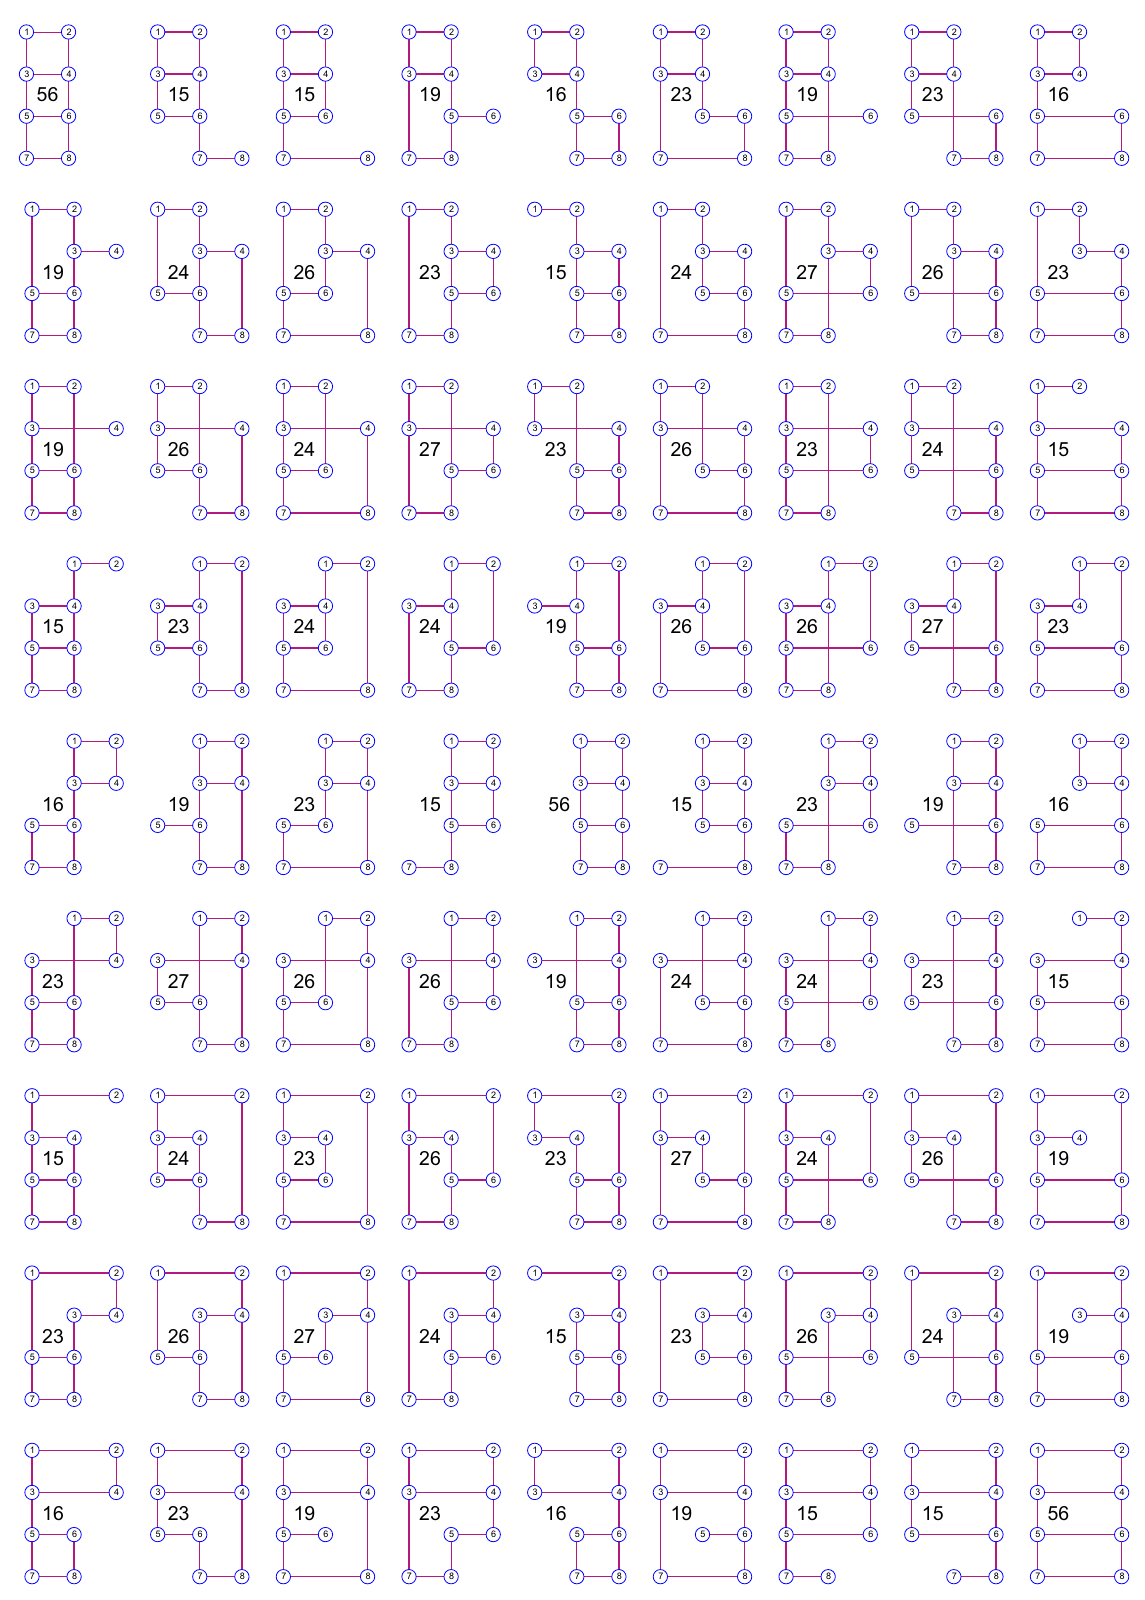
Fig. 11 Closed spin chain topologies with n = 4 rungs. There are in total 3 n = 81 topologies. Trivially, the set of topologies found in the OSC (Fig. 10 ) is contained as a subset here. The corresponding complexity for each graph is